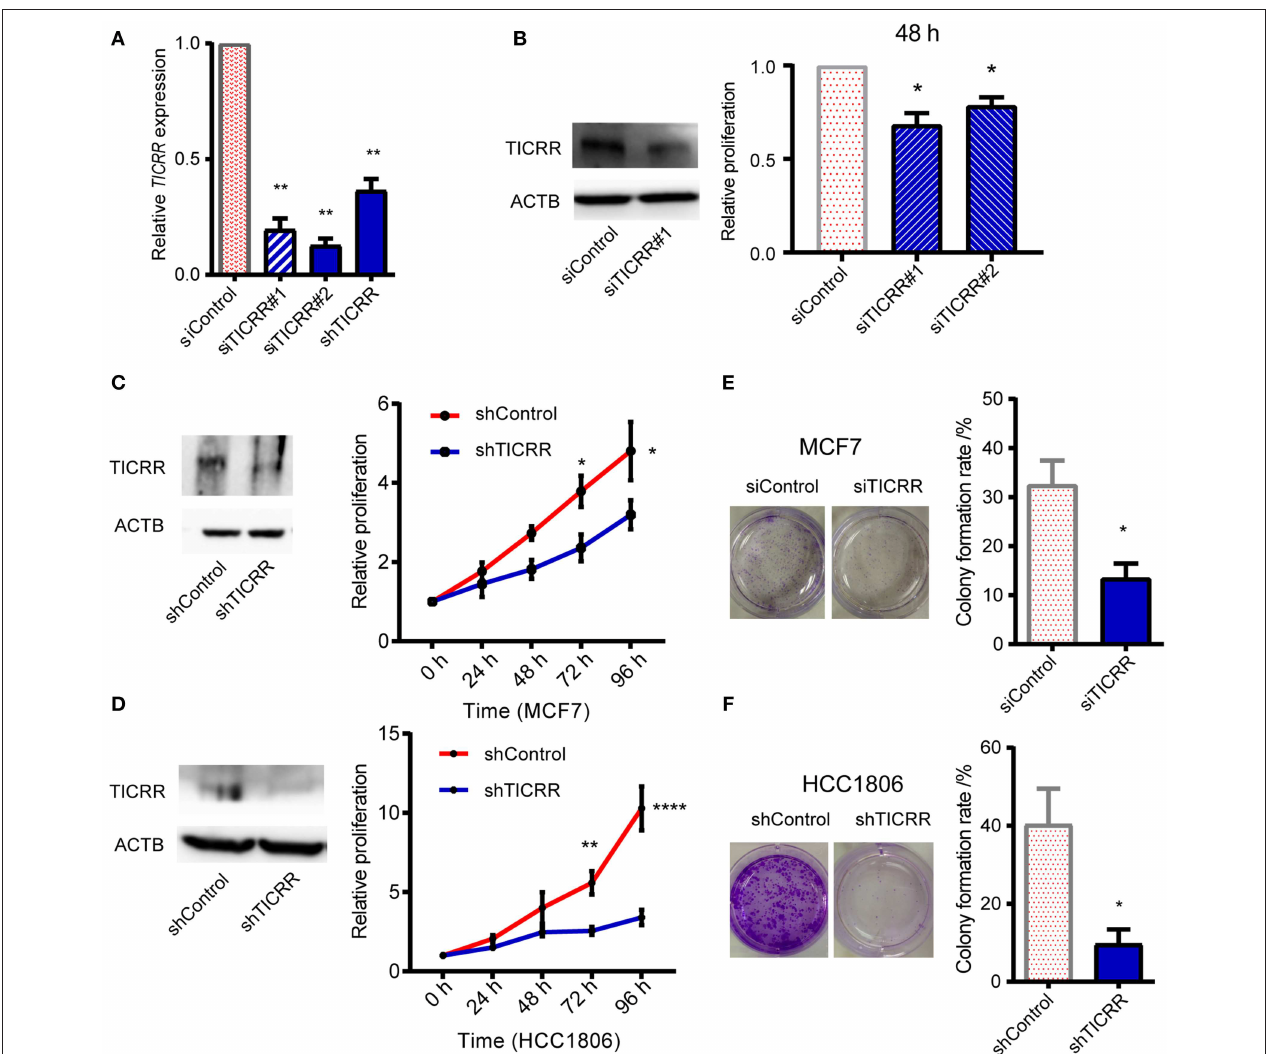
FIGURE 2 | Knockdown of TICRR inhibited cell proliferation. (A) TICRR expression was inhibited in MCF7 cells using siRNA and shRNA. Efficiency of TICRR knockdown evaluated by RT-qPCR. Data were mean ± SEM, N = 3 biological replicates. (B) Relative proliferation in control and TICRR -knockdown MCF7 cells after transfection for 48h. Western blot (left) was performed. The proliferation in control cells was set at 1. * p < 0.05, two-tailed Student’s t -test. Data were mean ± SEM, N = 3 biological replicates. (C,D) Growth curves of TICRR -knockdown cells and control in MCF7 (C) and HCC1806 (D) cell lines. western blot (left) was performed. Cell viability at 0h was set at 1. * p < 0.05, ** p < 0.01, **** p < 1.0 × 10 − 4 , two-way ANOVA test. Results were displayed as means ± SEM, N = 3 biological replicates. (E,F) Knockdown of TICRR inhibited the colony formation in MCF7 (E) and HCC1806 (F) cells examined by plate colony formation assay. Representative colonies pictures were shown on the left and percentage of colony number were on the right. * p < 0.05, two-tailed Student’s t -test. Results were displayed as means ± SEM, N = 3 biological